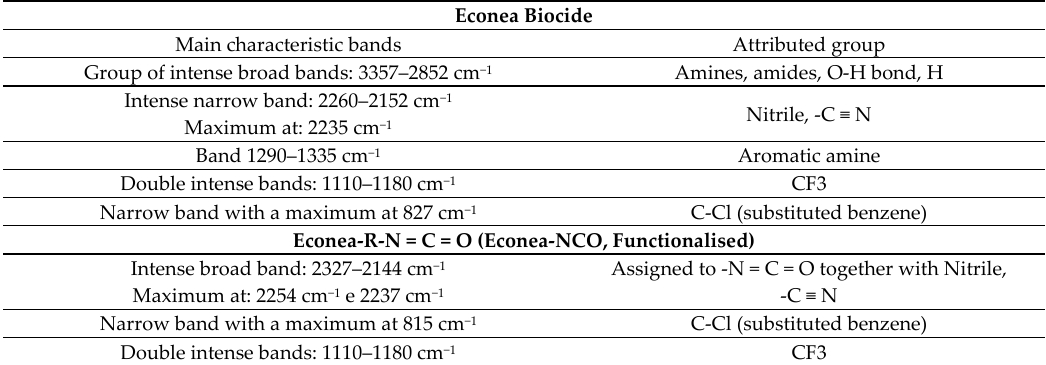
Figure 1. FTIR spectra of Econea and its functional counterpart, Econea-R-N = C = O. Table 1. Main obtained bands from infrared spectra (FTIR) analysis of Econea biocide and its functional counterpart Econea-R-N = C =